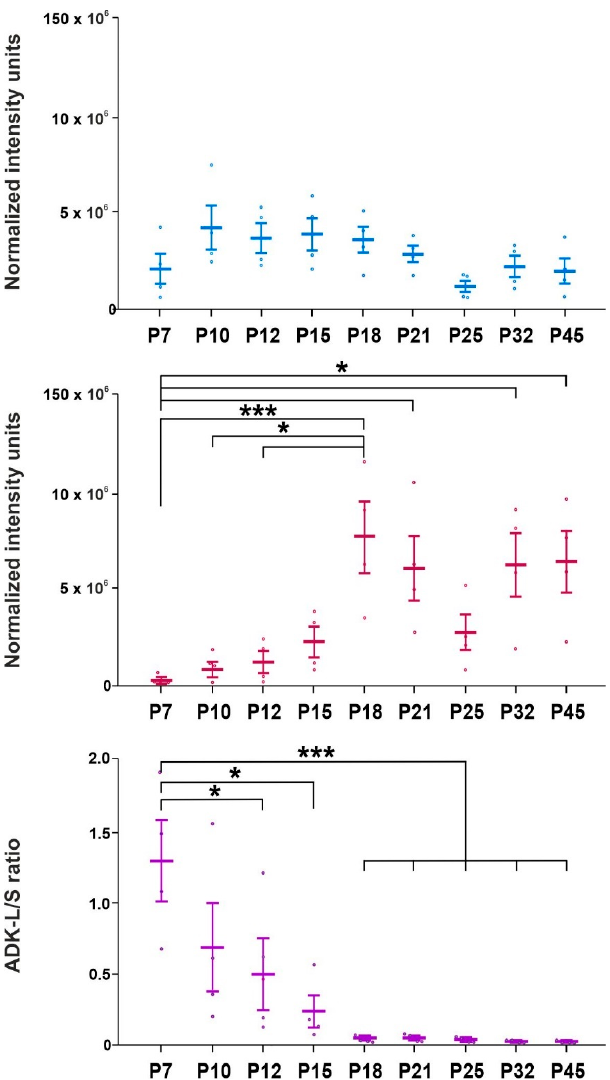
Figure 3. Analysis of ADK isoforms in controls, ADK-L and ADK-S (mean gray value + SEM), in nine age groups. From top to bottom: ADK-L in controls, ADK-S in controls, ADK-L/-S ratio in controls. Abscissae from left to right: 7-, 10-, 12-, 15-, 18-, 21-, 25-, 32-, and 45-day-old rats; ordinates: normalized intensity units or ratio (see inset). One or three asterisks denote a significant difference for * p < 0.01 or *** p < 0.001, respectively (details, see inset).